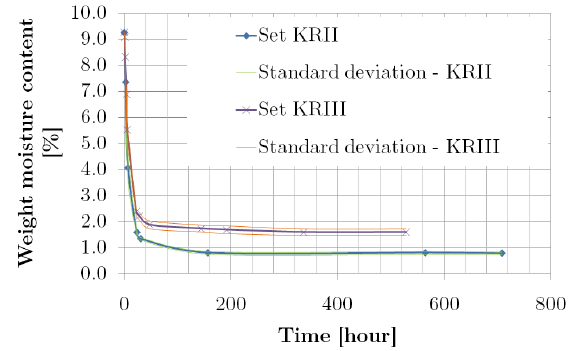
Figure 7. Time course of weight moisture content.